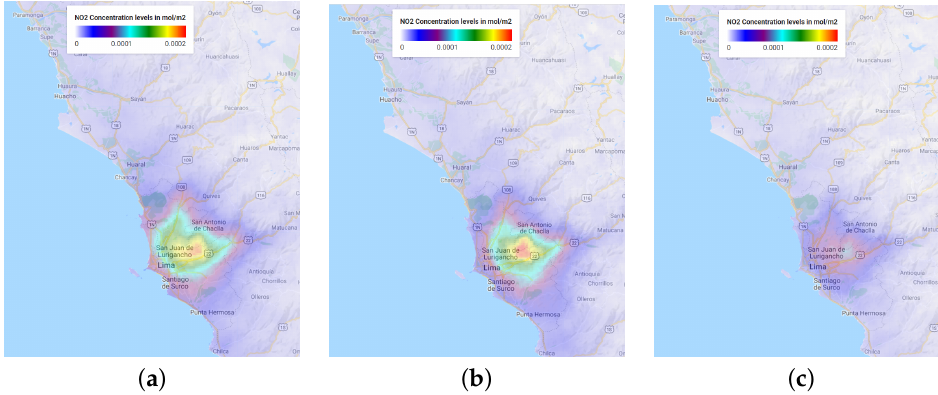
Figure 2. Satellite data information, in terms of the NO 2 concentration levels in mol/m 2 for the Lima metropolitan area. ( a ) 2018 June–December. ( b ) 2019 January–June. ( c ) 2020 January–June. The image shown corresponds to approximately 175 by 210 km. In all cases, the color bars indicate the NO 2 concentration levels on a scale of a minimum value of 0 and a maximum value of 0.0002 mol/m 2 as described in task five in Section 2.2.